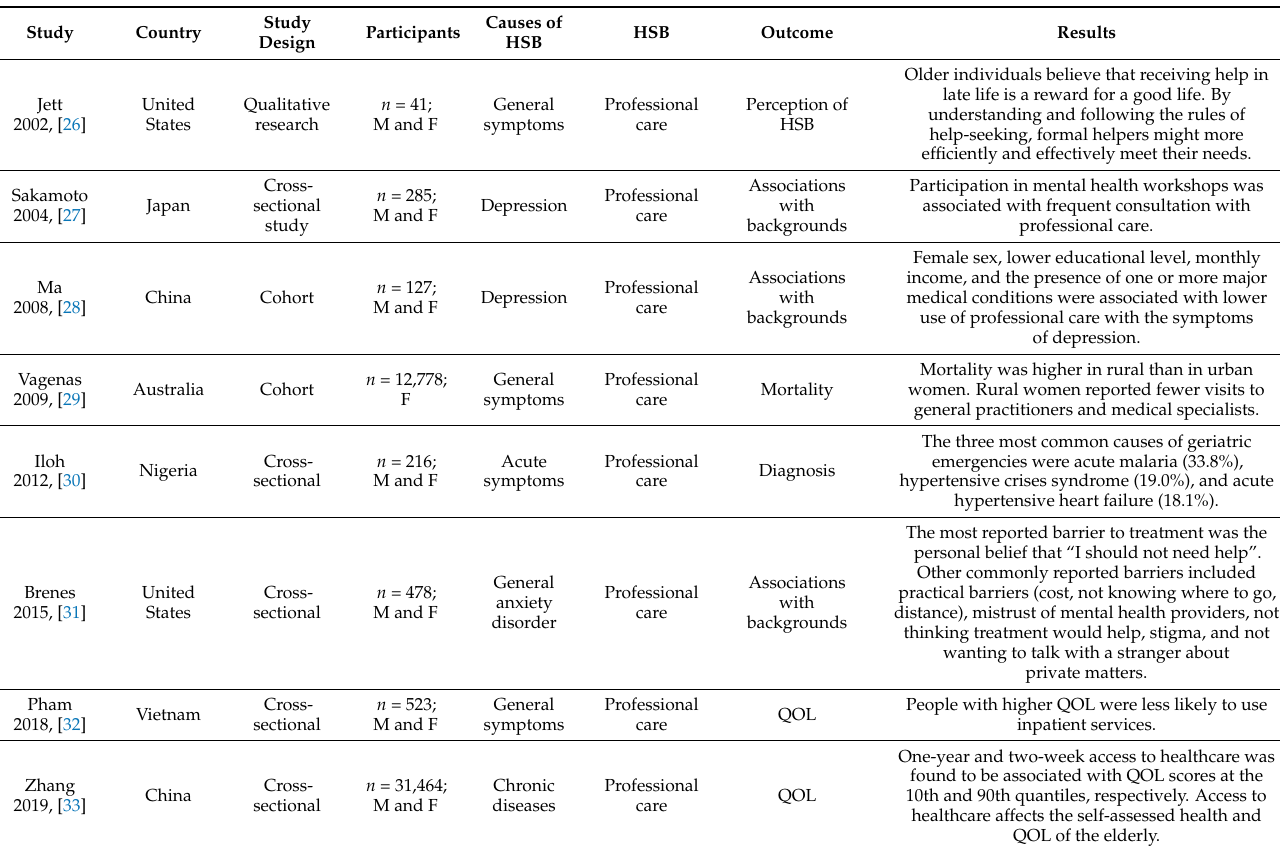
Figure 1. Flowchart of study selection. Table 2. Studies reporting rural older individuals’ HSBs.